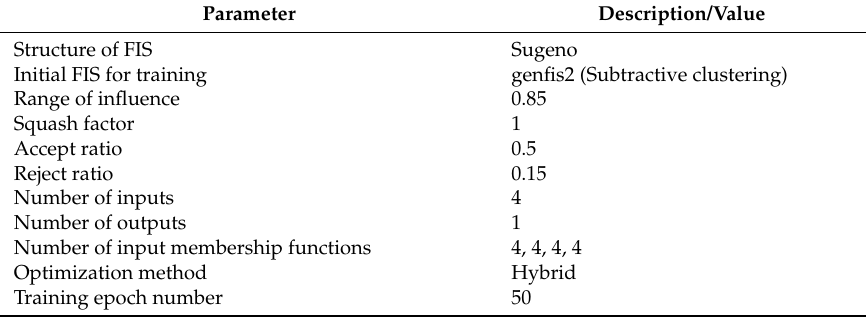
Table 3. Specifications of the developed adaptive neuro-fuzzy inference system (ANFIS) model.